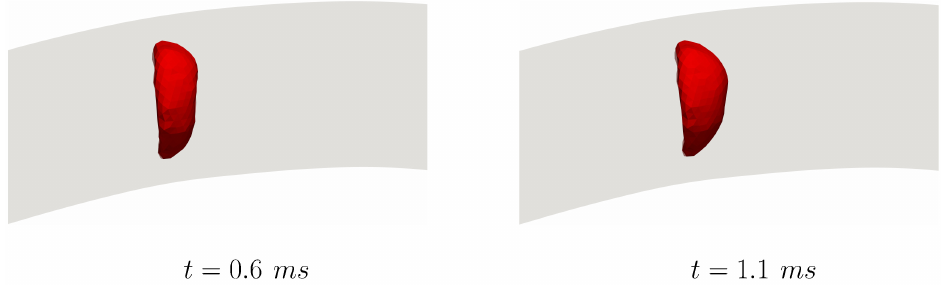
Figure 13. Deformation of the RBC from the biconcave shape into the parachute shape in a curved tube. The shape of the RBC is shown at t = 0.6 and 1.1 milliseconds. The tube boundary is shown in the